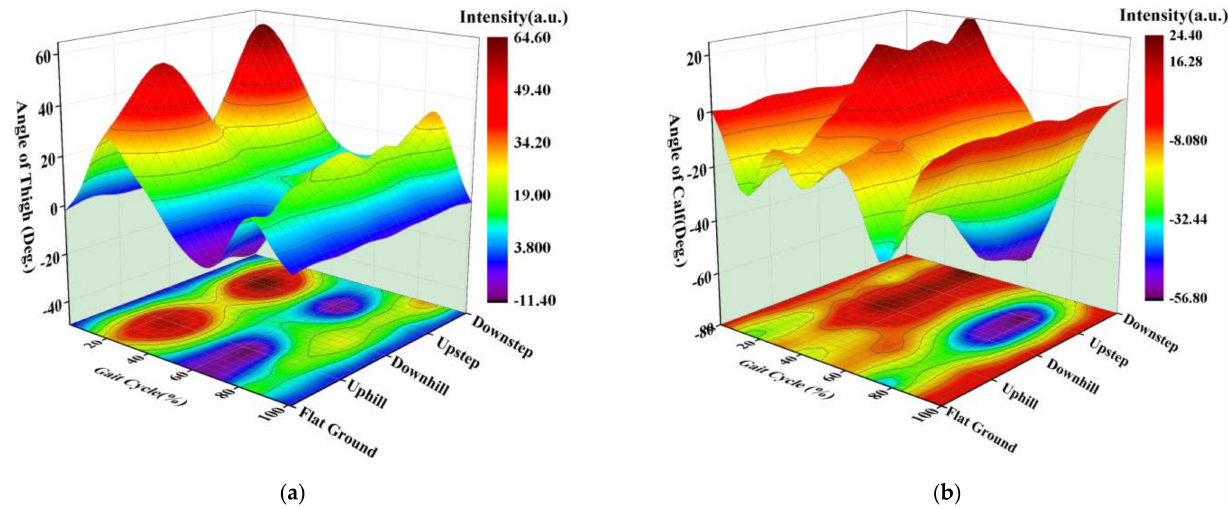
Figure 11. Angle of the lower limb in different gaits. ( a ) Thigh angle in different gaits; ( b ) calf angle in different